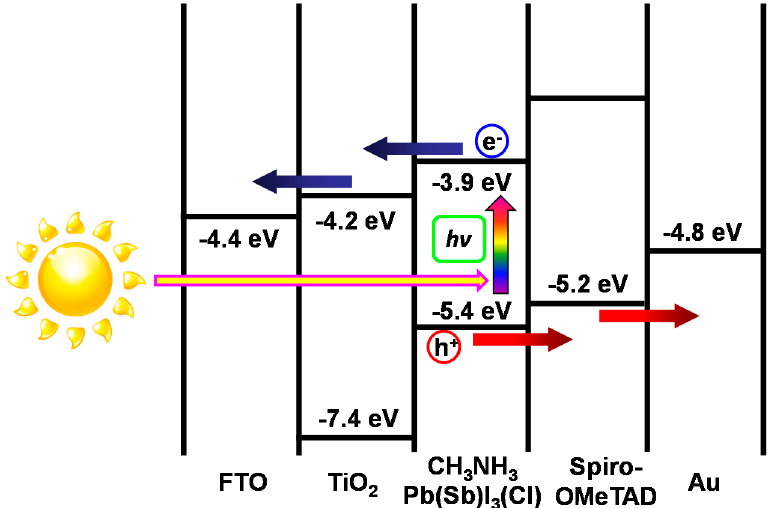
Figure 10. Energy level diagram of CH 3 NH 3 Pb(Sb)I 3 (Cl) cells.